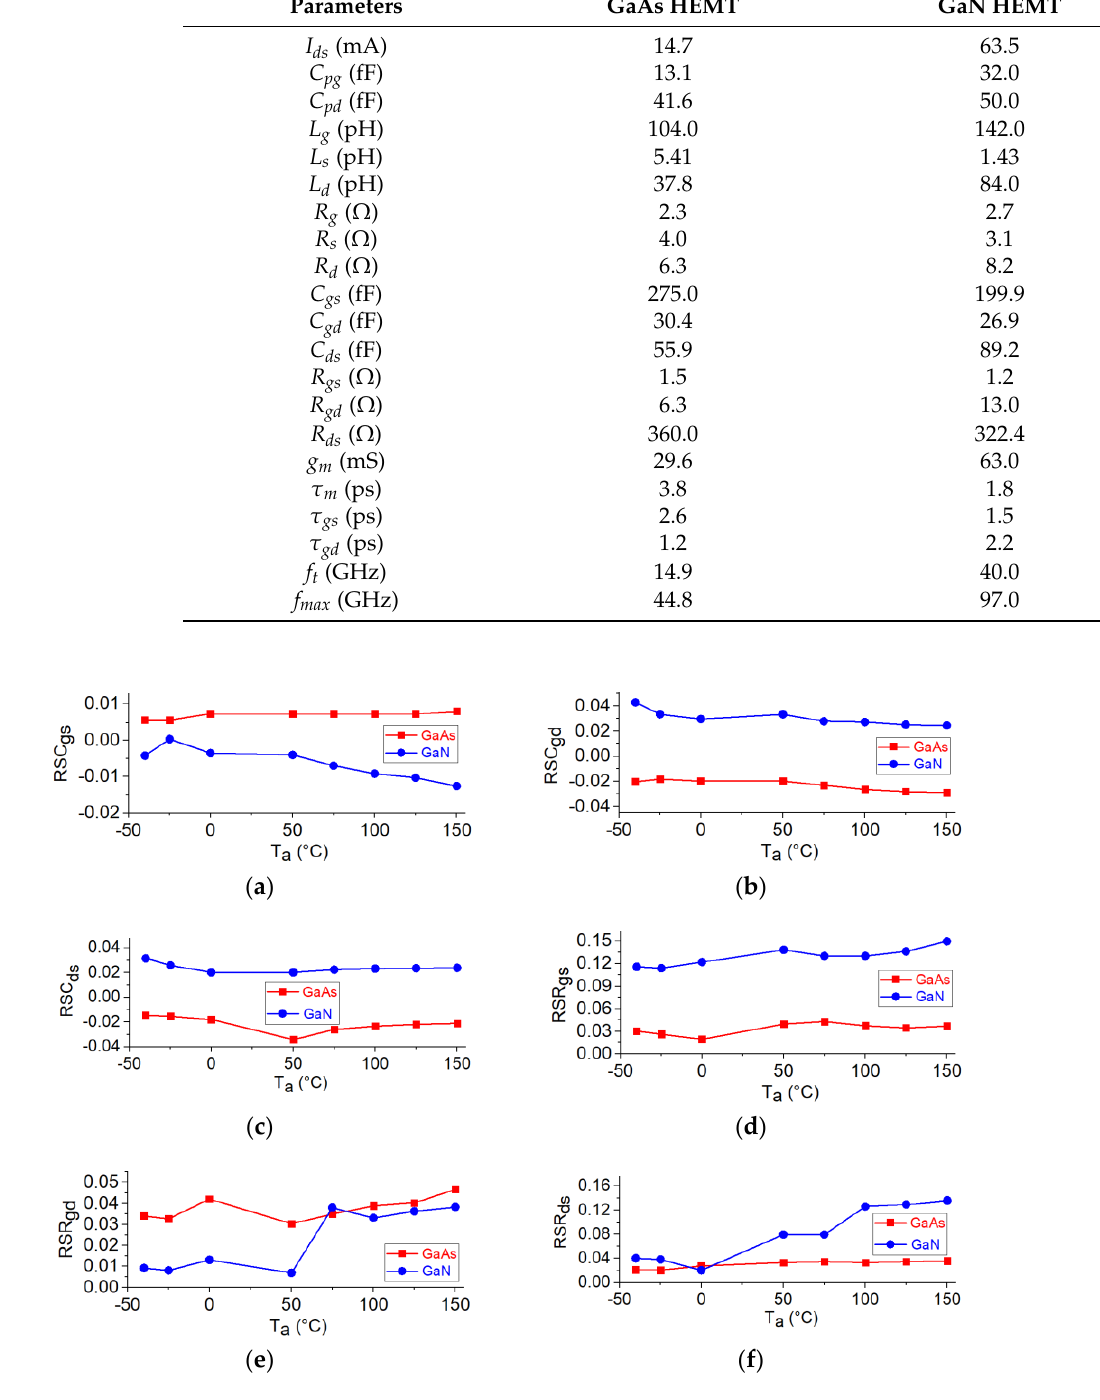
Figure 10. Behavior of the relative sensitivities of the intrinsic resistances and capacitances versus T a for the two studied devices. The illustrated bias points are: V ds = 3 V and V gs = − 0.1 V for the GaAs HEMT and V ds = 9 V and V gs = − 4 V for the GaN